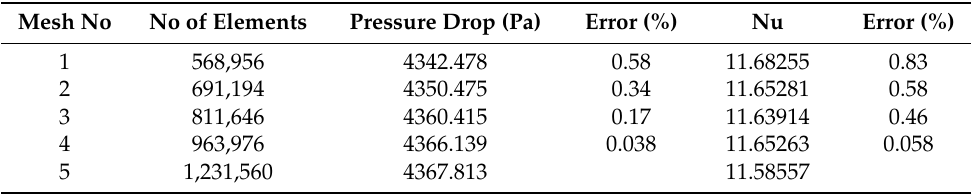
Table 2. Mesh independence